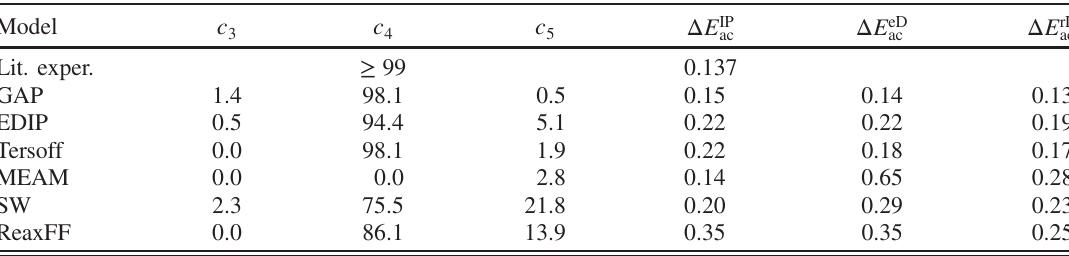
TABLE II. Coordination statistics c percent) and energy per atom relative to the diamond structure ( Δ E quenching of the liquid. The energy difference evaluated using the interatomic potential is Δ IP of the interatomic-potential-relaxed structure evaluated (but not relaxed) using the DFT is Δ E eD evaluated energy difference of the DFT-relaxed structure starting from the interatomic potential structure is Δ E rD Most atoms in the MEAM structure have coordination ≥ 6 . The experimental defect density is from Ref. [160] and the energy from Ref. [161].